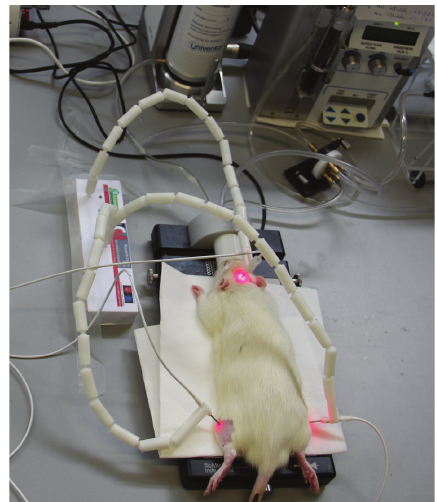
Figure 1: Anesthetic procedure and laser stimulation.